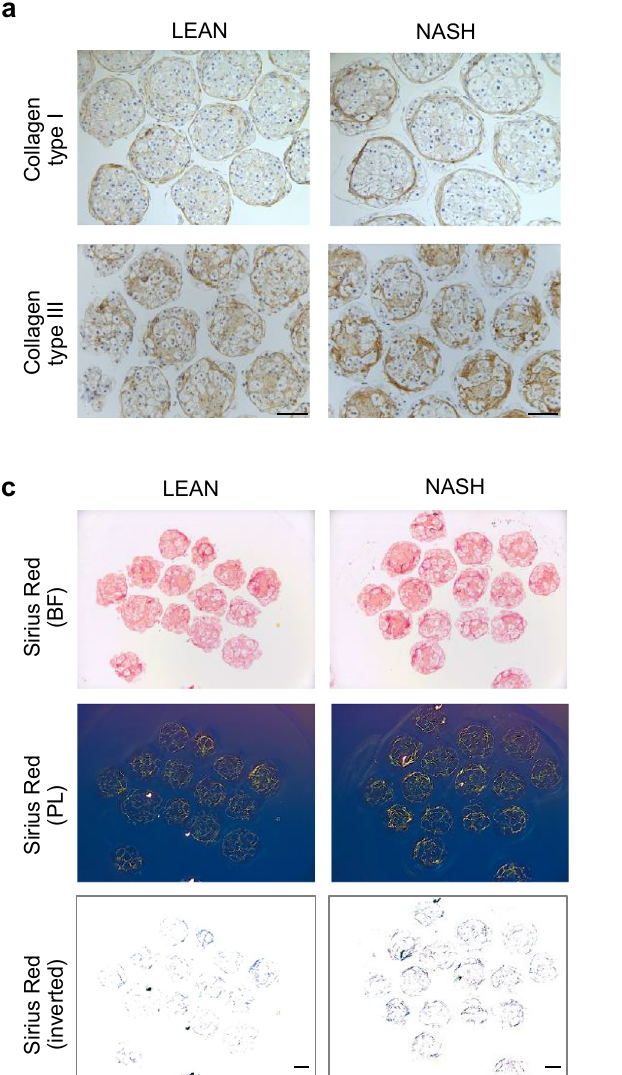
Figure 4. Induction of fibrosis in NASH-treated hLiMTs. ( a ) IHC analysis showed increased staining intensity of collagen type I and III in NASH vs. LEAN control hLiMTs. Scale bars indicate 100 μm. ( b ) Cleaved C-terminus pro-peptide of procollagen type I was measured in supernatants on day 7 and 10 and was normalized to secretion per hLiMT and per day. NASH-treated samples showed a significant increase (*p < 0.05) in procollagen I release compared to LEAN control hLiMTs (3 independent experiments, n = 12 for NASH and LEAN). ( c ) Sirius Red staining and polarized light microscopy of tissue sections showing collagen fibrillation. The results demonstrated an increased collagen fibrillation in NASH vs. LEAN control treated hLiMTs. Polarized light images are shown as inverted images for improved visualization. Scale bars indicate 100